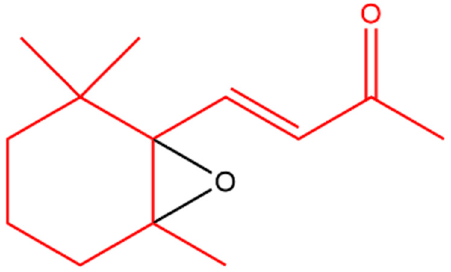
Figure 7. 5,6-Epoxy- β -ionone. The β -ionone moiety is shown in red.